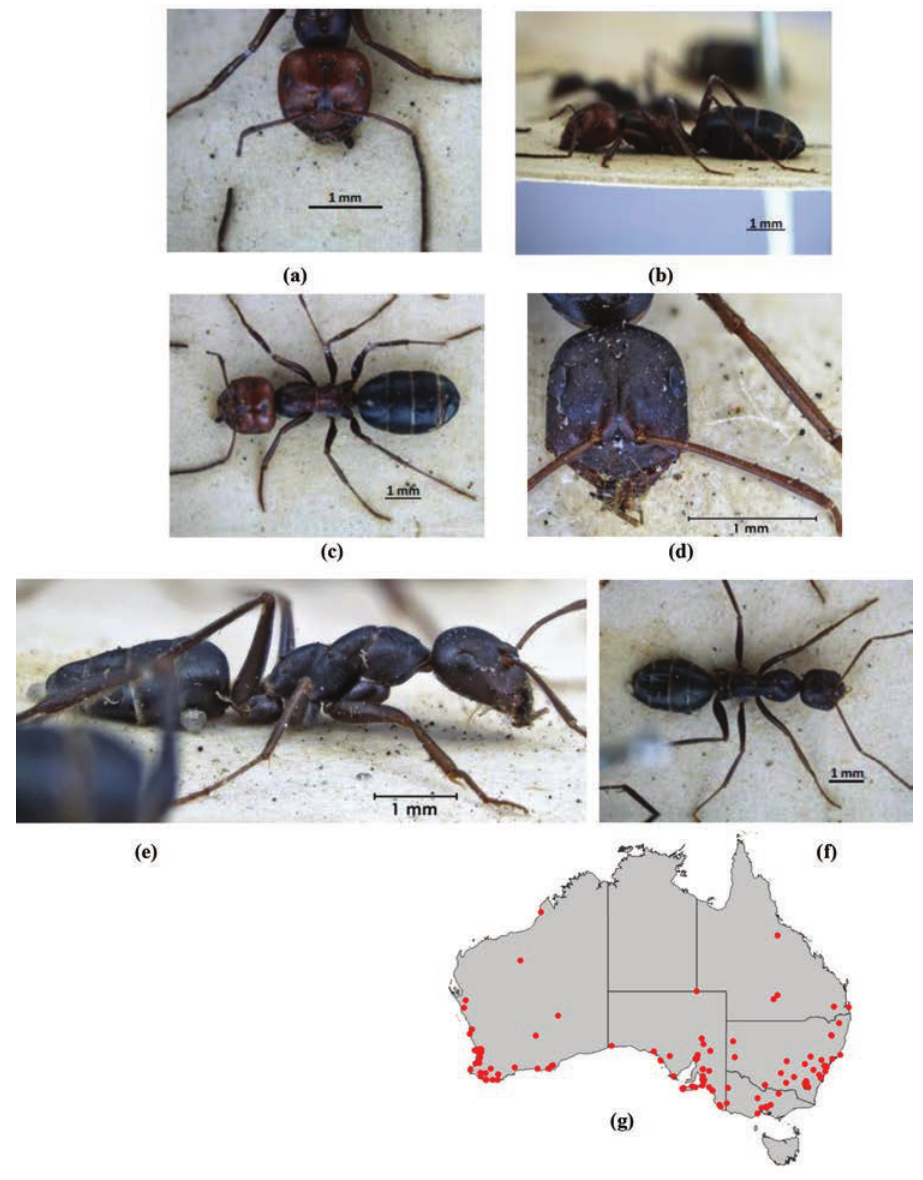
Figure 6. Melophorus aeneovirens (Lowne): BMNH major worker syntype frons ( a ), profile ( b ) and dorsum ( c ); BMNH minor worker syntype frons ( d ), profile ( e ) and dorsum ( f ); distribution map for the species ( g ). Sevenhill (Lowery, B.B.), Victor Harbour (Greenslade, P.J.M.), West Bay, Kangaroo Island (Greenslade, P.J.M.). Victoria : Anglesea (Andersen, A.N. [JDM32-001829]), 15 km WNW Yaapeet (Andersen, A.N.), Bendigo (McAreavey, J.), Big Desert